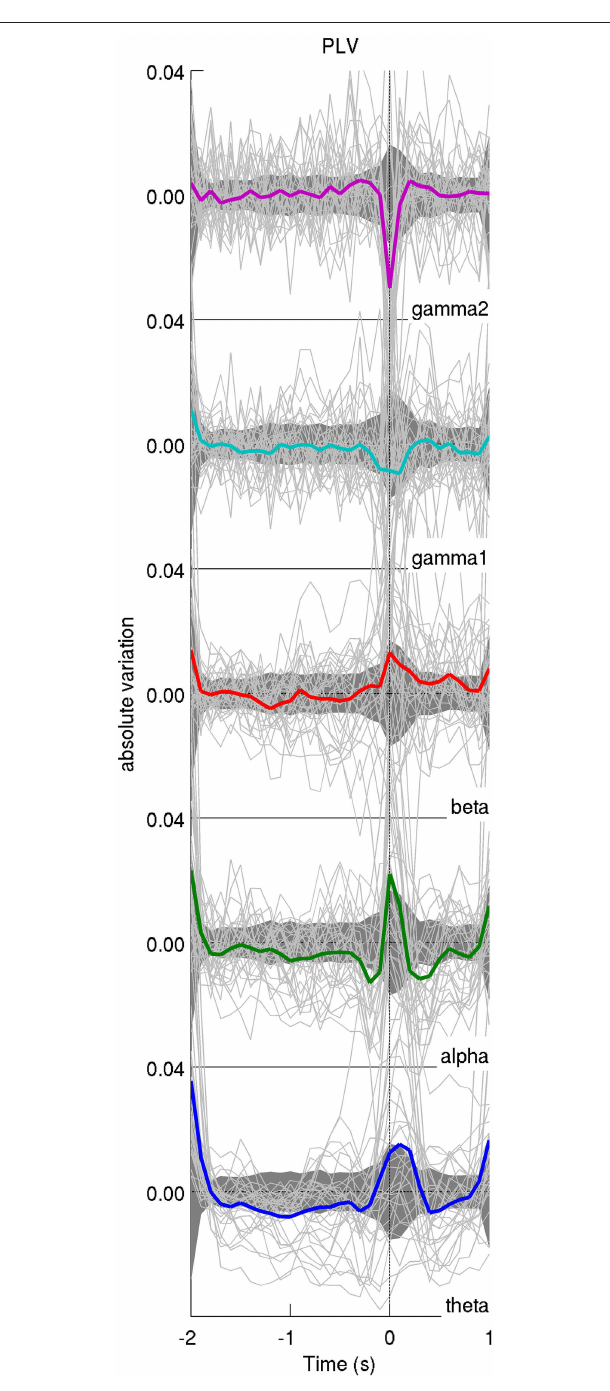
FIGURE 3 | Average time course of the iEEG functional connectivity. The average PLV across pairs of iEEG contacts for each patient is represented with a light solid line and the average across patients is displayed in thick colored lines. Confidence intervals for the average across patients are displayed as a dark shaded area. The time axis is centered on the peak of IEDs (time 0). In general, the average functional connectivity, as measured with the phase-locking value (PLV), increases at IED peak for lower frequency bands ( < 30Hz) and decreases for higher frequency bands ( > 30Hz). The y-axis displays absolute variation in terms of